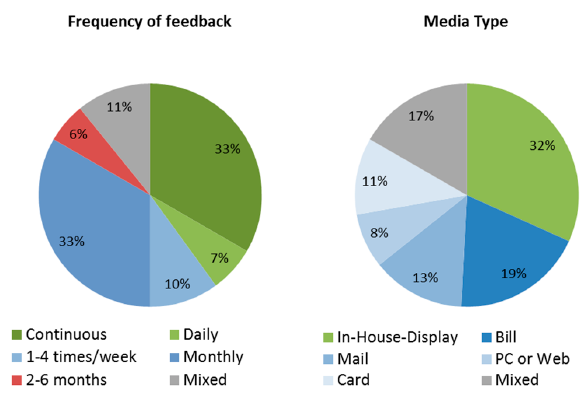
Figure 3. Breakdown of 127 feedback applications by main determinant factors.